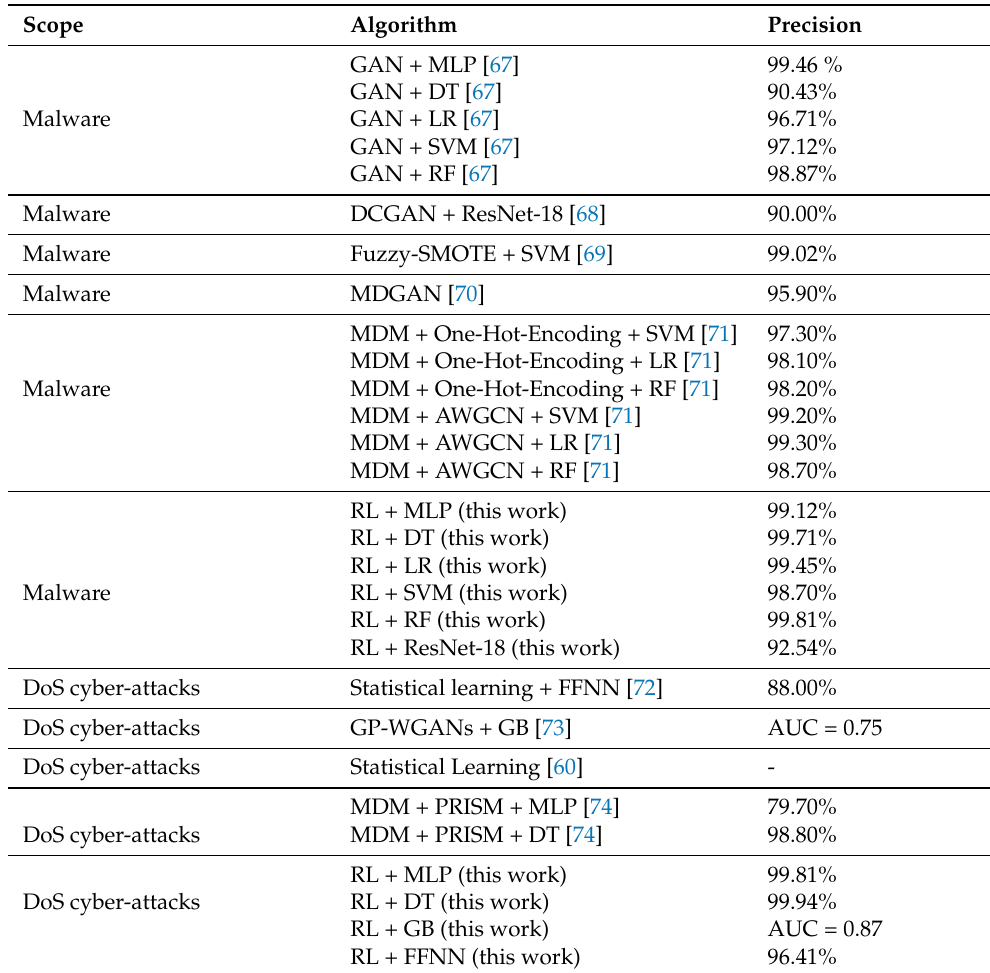
Table 9. State-of-the-art reported SL and DL algorithm results for comparison with this work (RL).